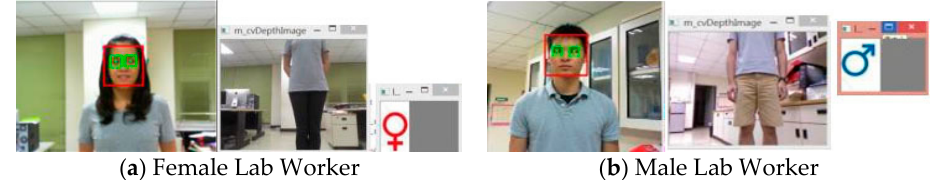
Figure 14. Examples of facial recognition and gender classification.